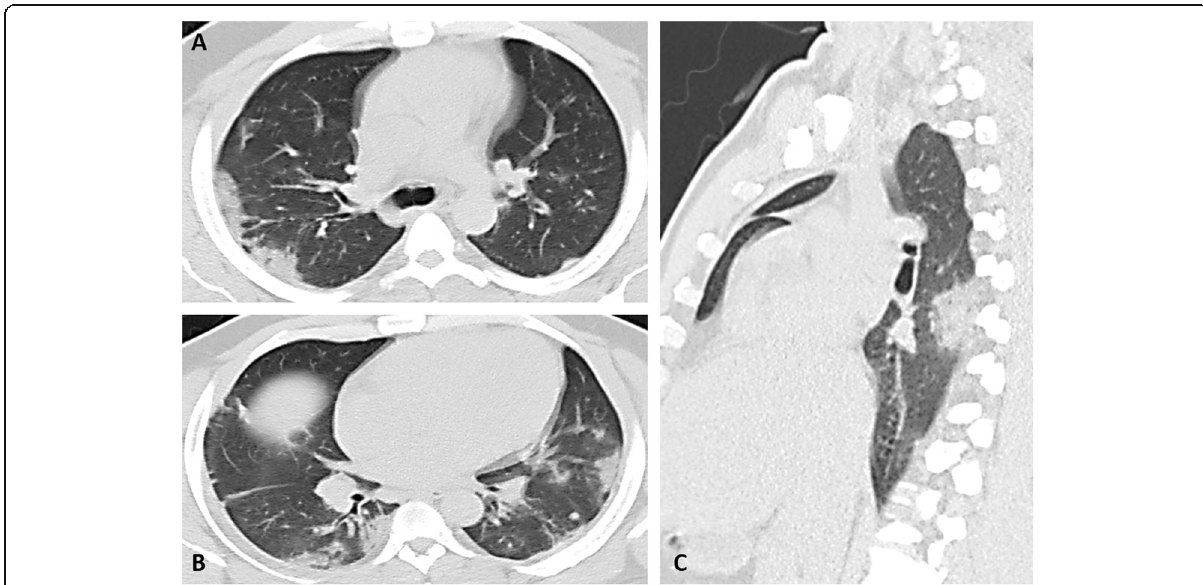
Fig. 3 Non-contrast CT of a 52-year-old male with fever and shortness of breath, rt RT-PCR +VE ( A - C ): A and B axial, and C sagittal non-contrast CT scan lung window show bilateral multiple subpleural areas of consolidation associated with linear opacities and pleural thickening